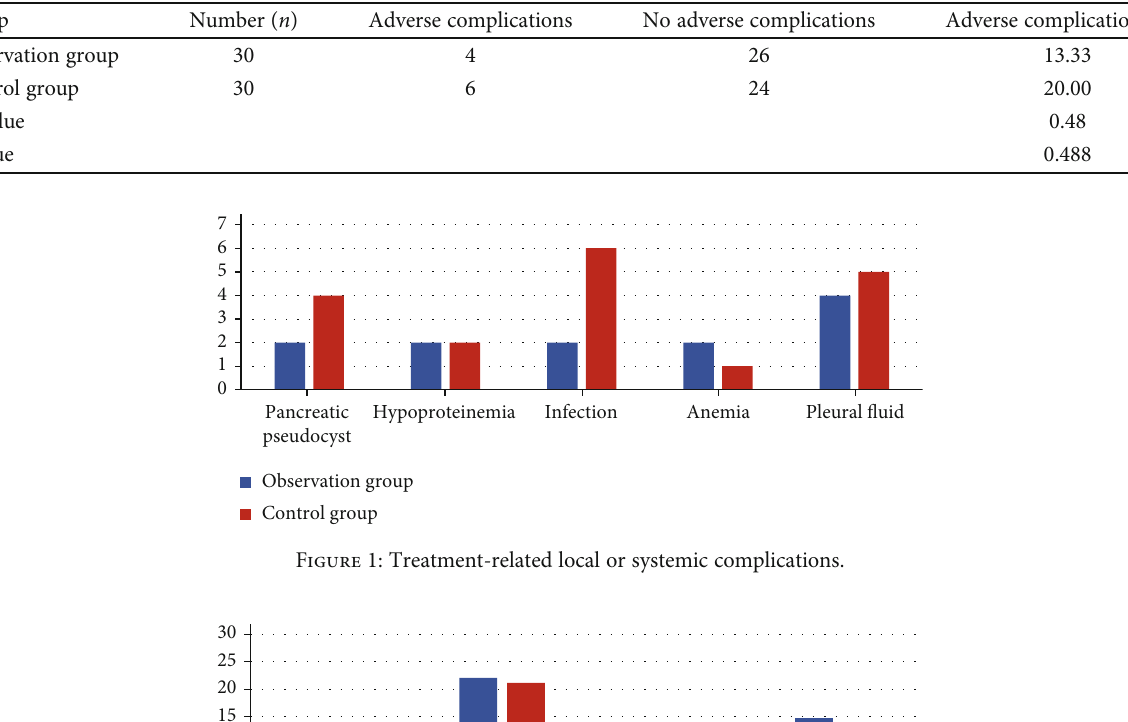
Table 3: Statistical analysis of complications during treatment of two groups of patients ( n , %).